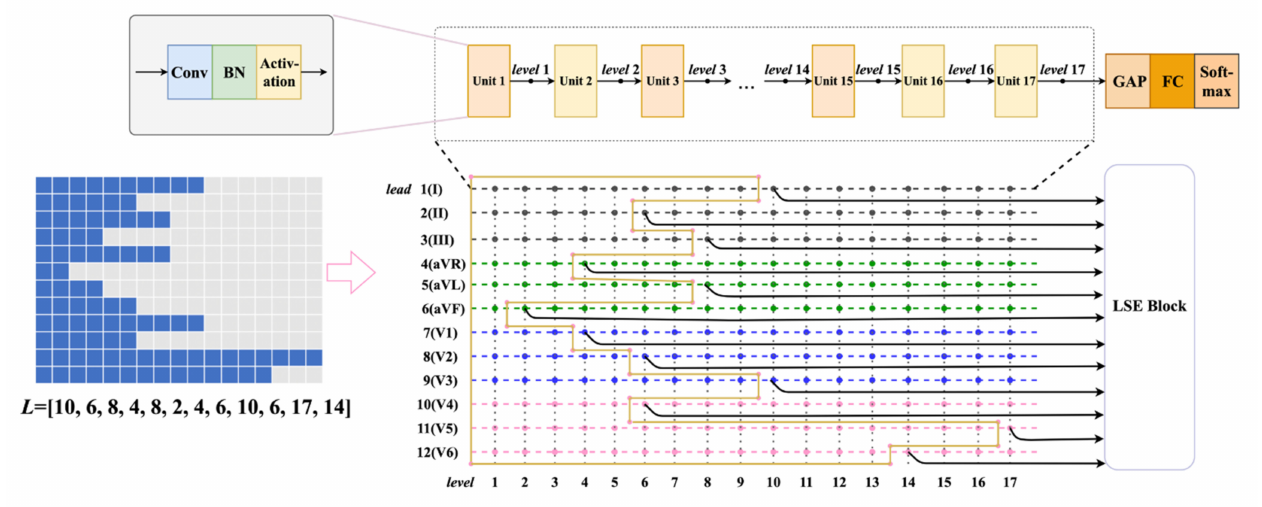
Figure 8. The diagram of the proposed